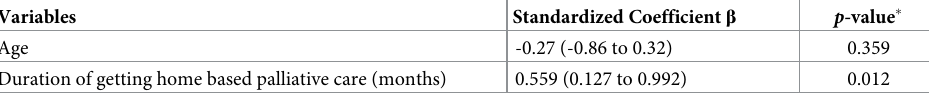
Multiple linear regression analysis (adjusted) was computed and all the precisions were estimated at 95% confidence interval � The standardized coefficient β was statistically significant at a threshold of p <